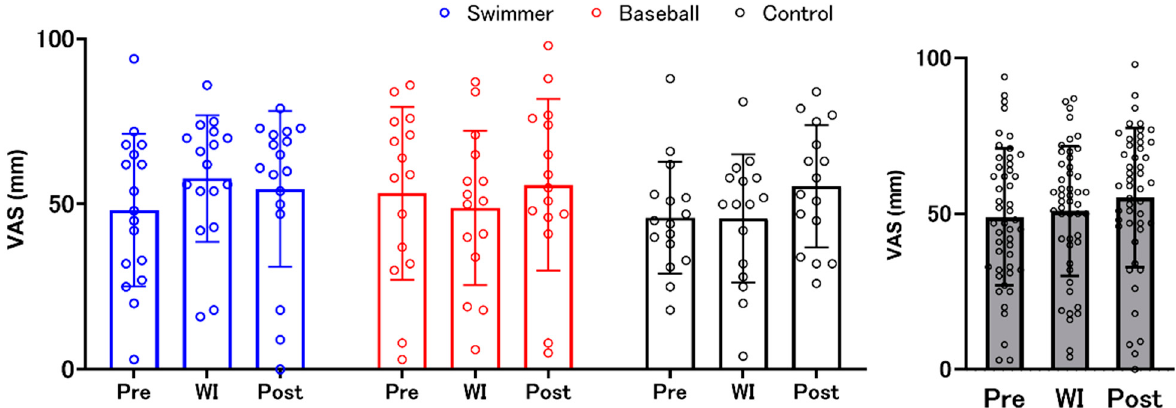
Figure 3. The confidence level for their answers. Blue, red, and black bars indicate the swimmer, baseball, and control groups, respectively. There was no significant difference among the groups. Gray bars represent all participants with individual data (open circles). VAS: visual analogue scale. WI: water immersion.